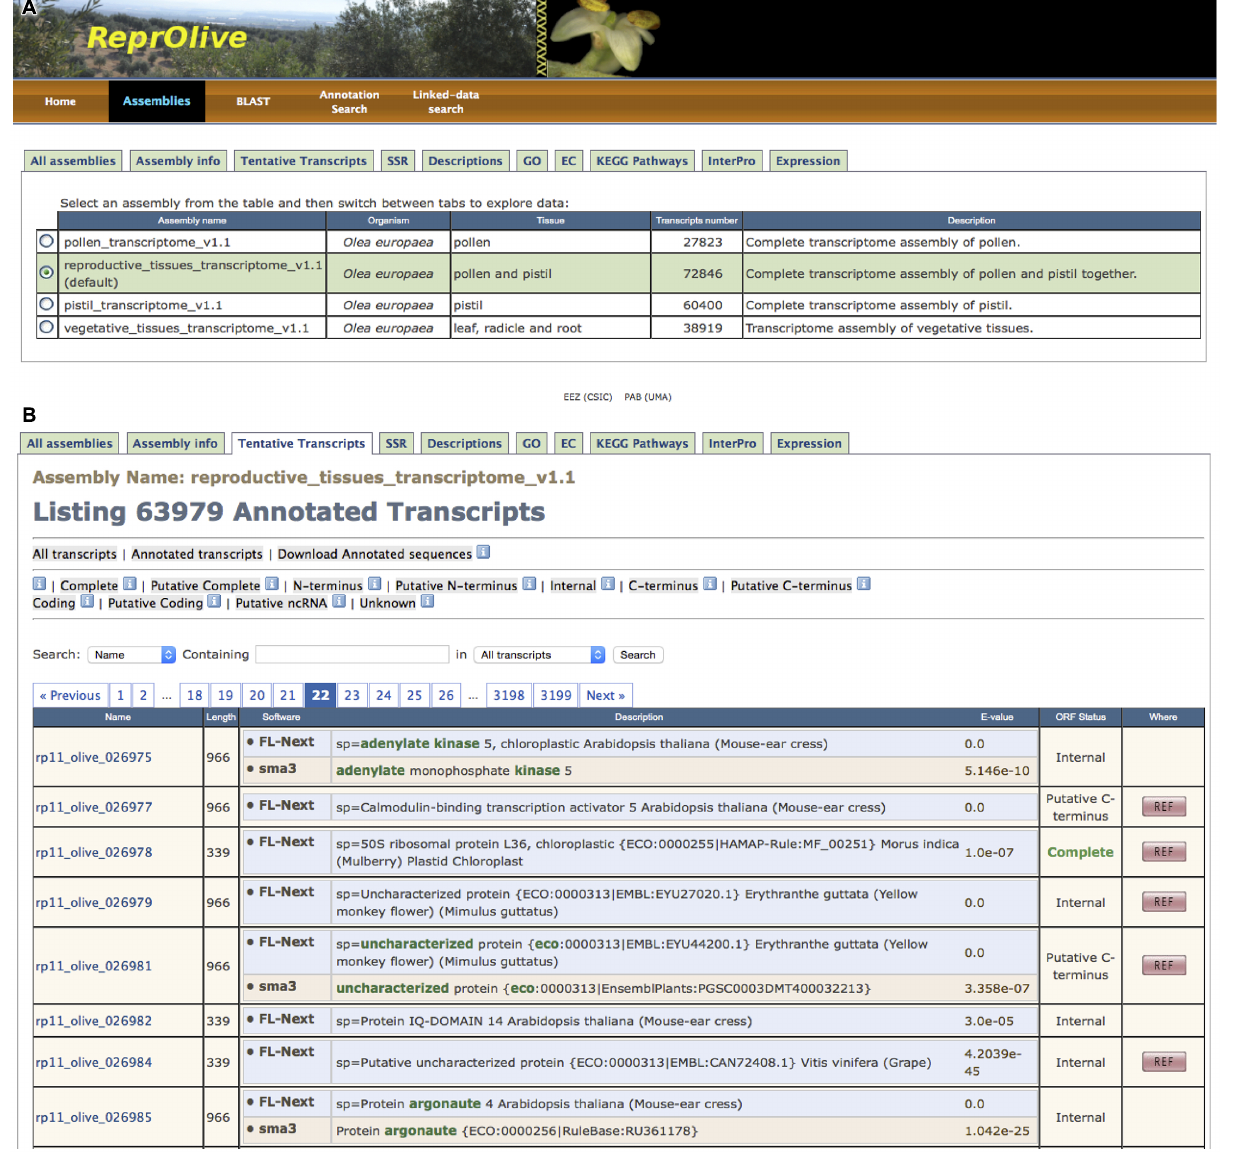
FIGURE 2 | Screen captures providing a general overview of ReprOlive. (A) “All assemblies” panel showing the four transcriptomes included in the database. (B) First page of “Tentative transcript (TTs)” panel, where filtering criteria are accessible and information about each TT is displayed (see text for details). TTs are shown in pages of 20